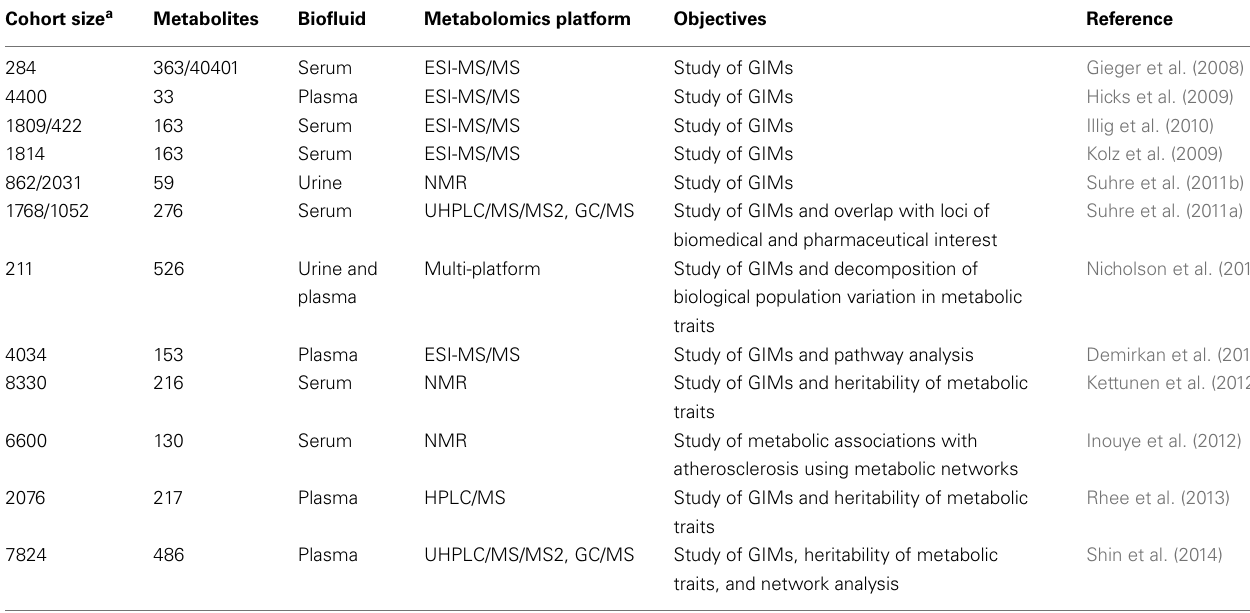
Table 4 | List of studies integrating genomics and metabolomics data